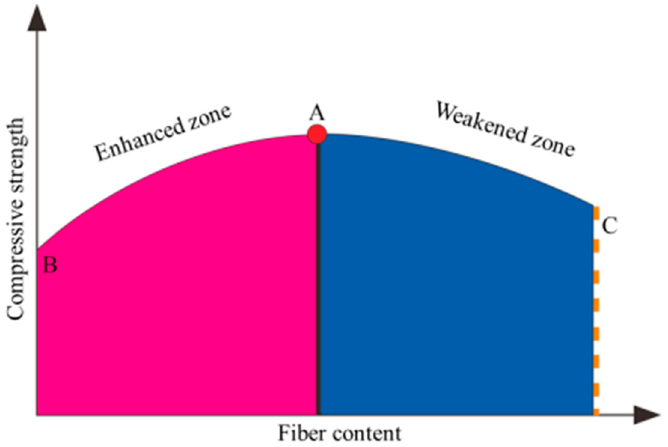
Figure 1. PVA fiber improves concrete strength [8].